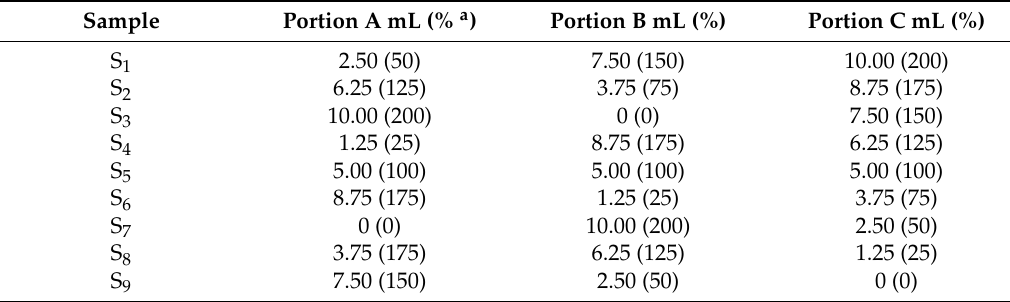
Table 7. Volumes and percentage of three portions in nine GBE samples.